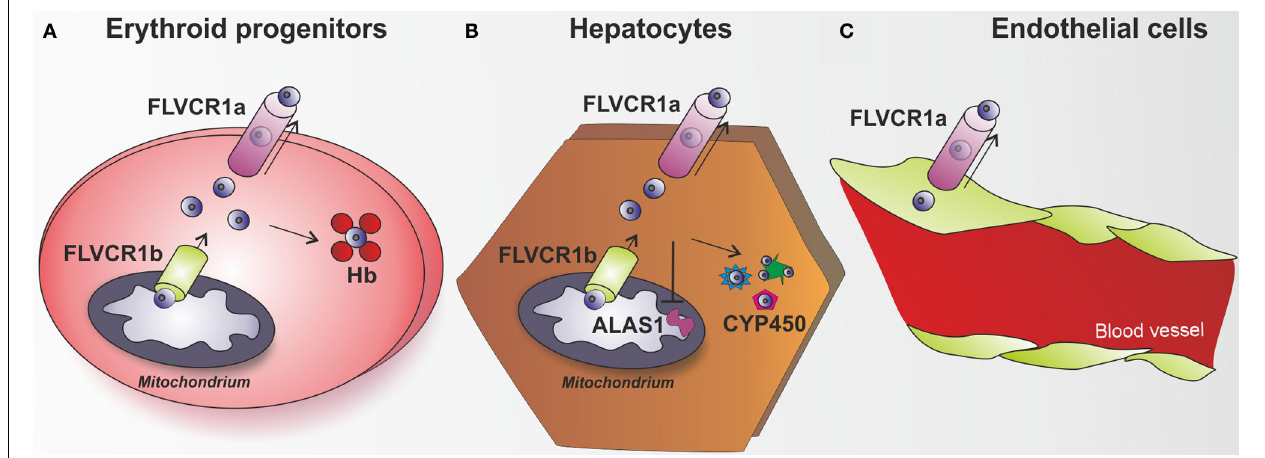
FIGURE 4 | The heme exporter FLVCR1a acts as a new heme detoxifying system. (A) Erythroid progenitors are able to synthesize and handle high amount of heme, in view of their hemoglobin (Hb)-mediated oxygen transport activity. FLVCR1b acts as a mitochondrial heme exporter to allow newly formed heme release from the mitochondrion to the cytosol, where it is incorporated into hemoproteins. FLVCR1a has been described as a system involved in the control of heme levels inside erythroid progenitors. By mediating heme export out of these cells, FLVCR1a regulates intracellular heme amount, thus limiting free heme toxicity and oxidative damage. (B) Hepatocytes have the highest rate of heme synthesis after the erythroid progenitors. Hepatic heme is mostly used for synthesis of P450 enzymes, which metabolize endogenous compounds and xenobiotics. FLVCR1a mediates heme export out of